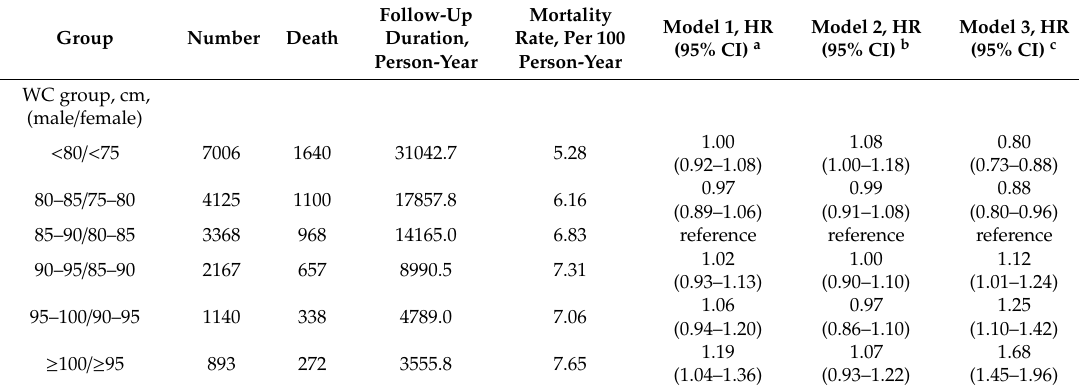
Figure 3. Smoothed hazard ratios curves of the associations of BMI and WC with all ‐ cause mortality in hemodialysis patients, stratified by age and sex. Log hazard ratios are adjusted for age; smoking status; alcohol consumption; regular exercise status; low income; previous history of diabetes, hypertension, dyslipidemia, cardiovascular disease and cancer; and BMI or WC. BMI, body mass index; WC, waist circumference; CI, confidence interval. 3.3. Subgroup Analyses of the Association of Obesity and Abdominal Obesity with All ‐ Cause Mortality According to the BMI or WC Level We further explored the associations between all ‐ cause mortality and obesity and abdominal obesity after stratifying patients into the five BMI categories and six WC categories. Notably, an increased mortality rate was observed among patients with a lower BMI and higher WC, whereas a